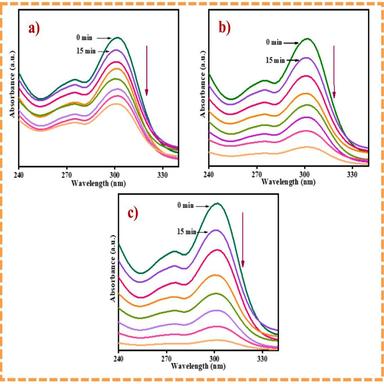
The absorption spectrum of omeprazole in the presence of (a) NF-ldh, (b) NF-ldh/gCN, and (c) NF-ldh/MXene.